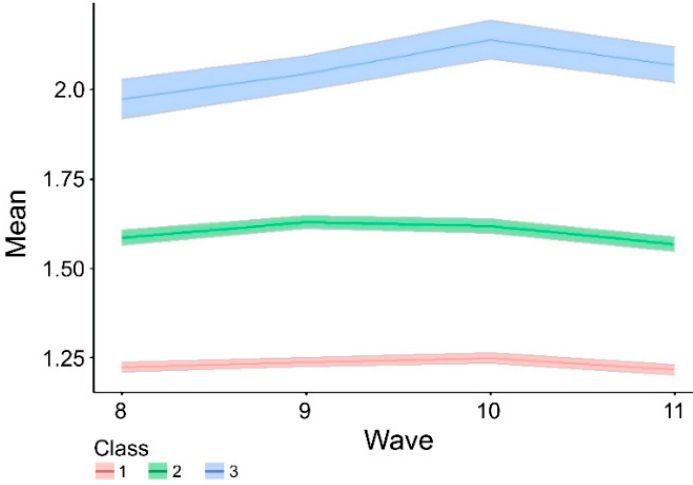
The most suitable model with low log-likelihood, AIC, BIC, and SABIC values and high entropy values is the model with three latent layers.